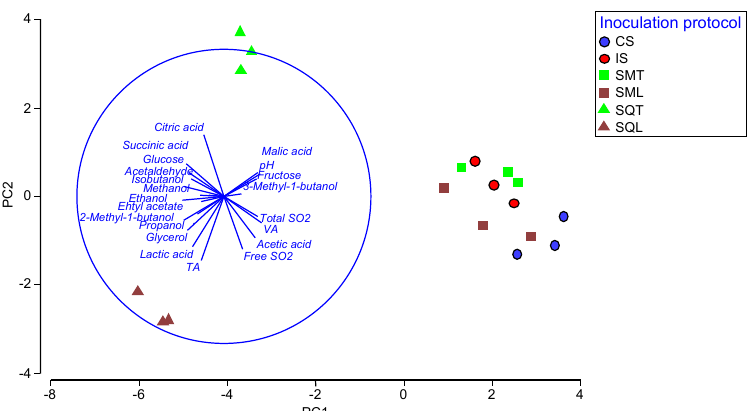
Figure 2. Principal Component Analysis (PCA) of the chemical characteristics of the laboratory-scale produced wines. CS: commercial S. cerevisiae ; IS: S. cerevisiae ScS13; SMT: T. delbrueckii TdS6 and S. cerevisiae ScS13 added simultaneously; SQT: T. delbrueckii TdS6 and S. cerevisiae ScS13 added sequen- tially; SML: L. thermotolerans LtS1 and S. cerevisiae ScS13 added simultaneously; SQL: L. thermotolerans LtS1 and S. cerevisiae ScS13 added sequentially.